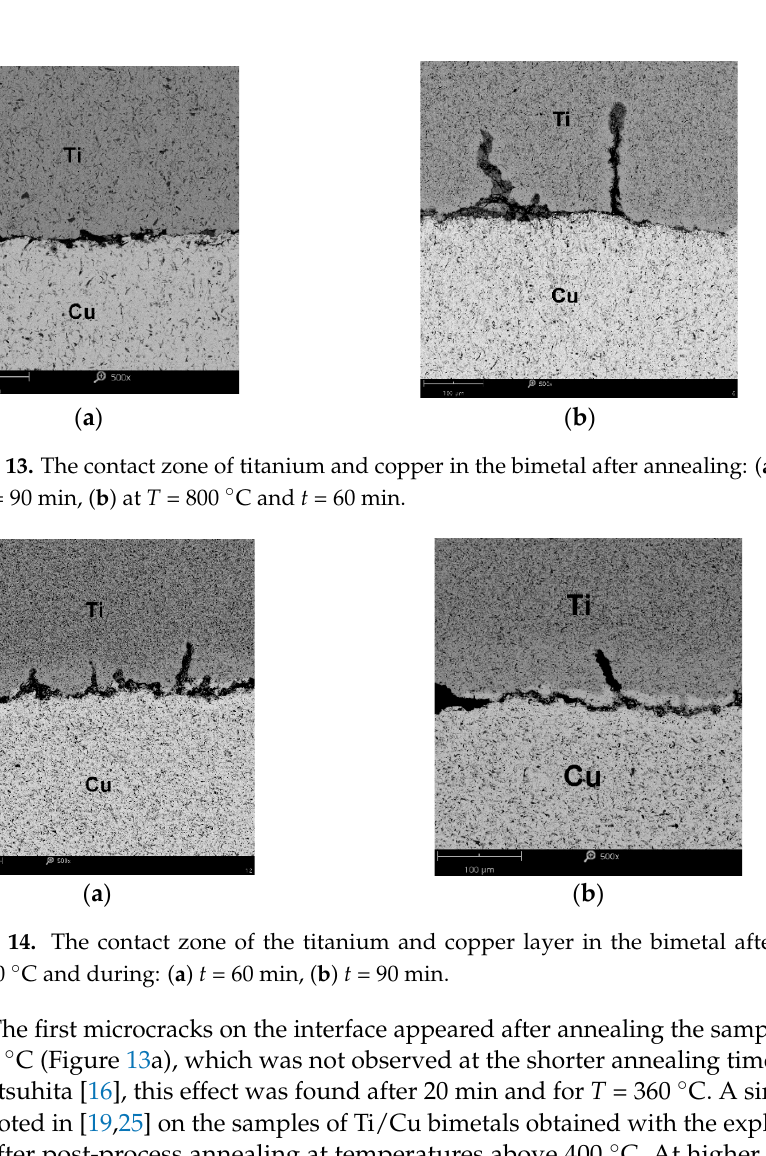
Figure 12. Contact zone of titanium and copper in the bimetal before the annealing process ( T = 20 °C): ( a ) SEM photo, ×500, ( b ) linear analysis of Ti and Cu distribution in the contact zone. Figures 13 and 14 show the characteristic zones of the joining of Ti and Cu layers.